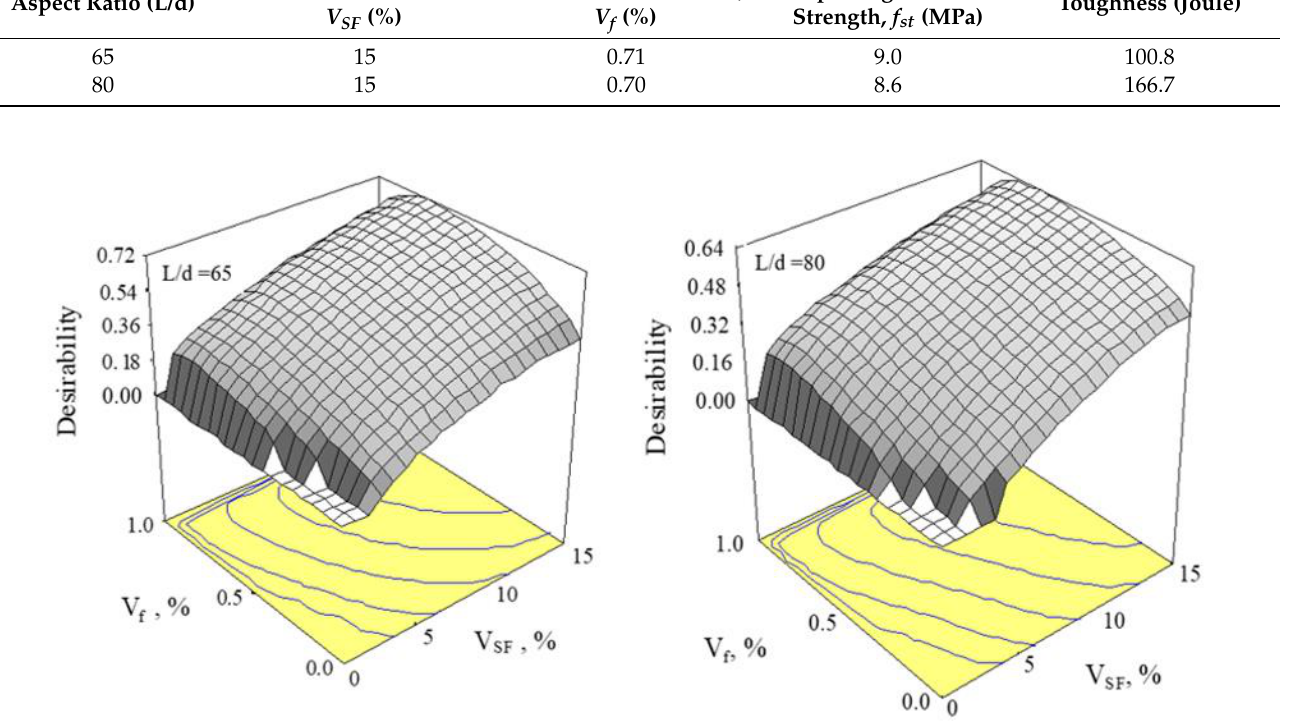
Figure 8. Desirability surfaces for optimal solutions.